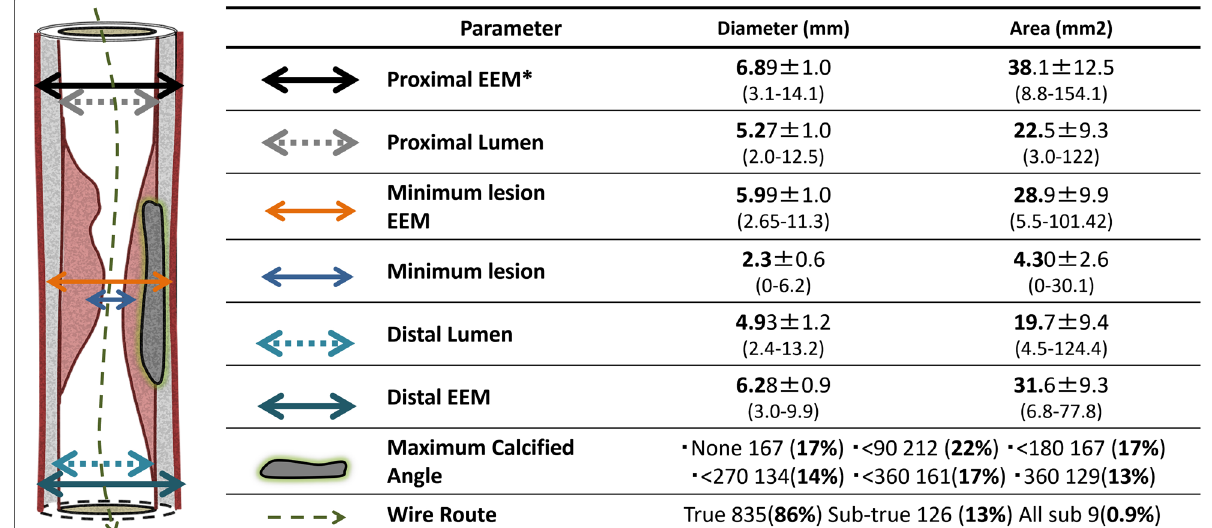
Fig. 1 Baseline intravascular ultrasound data. EEM: external elastic membrane